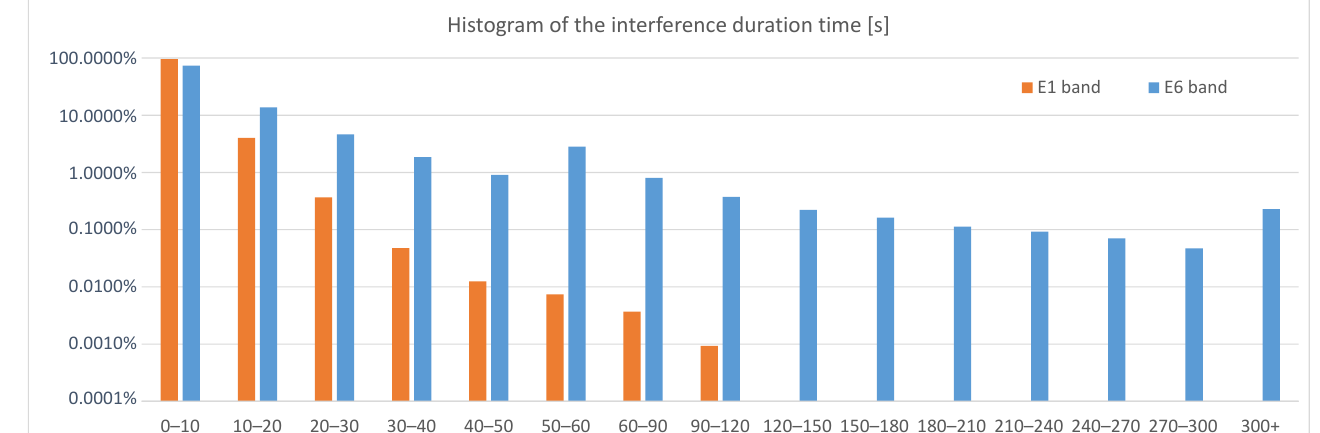
Figure 4. Histogram of the detected interference duration time in the E1 and E6 bands in Poland.